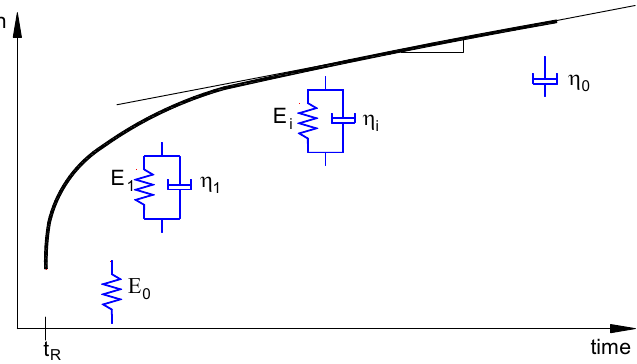
Figure 8. Schematic representation of the creep displacement with the Maxwell–Voigt–Kelvin model.